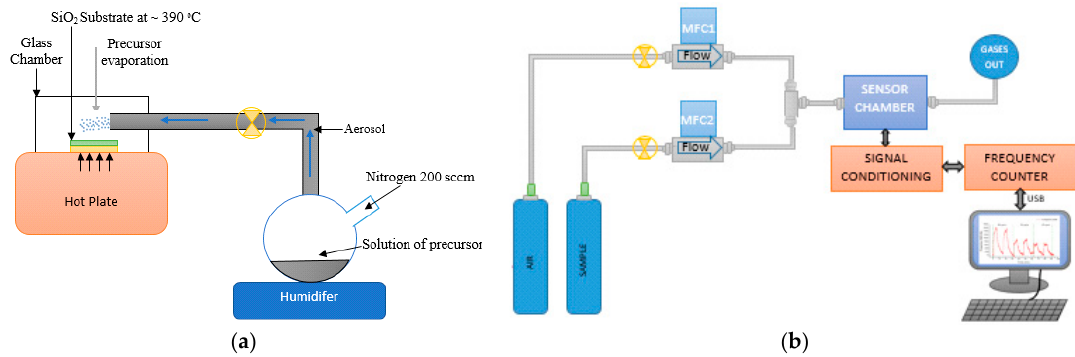
Figure2. ( a ) Basic scheme of aerosol assisted chemical vapour deposition technique; ( b ) Diagram of instrumentation and experimental setup for the gas sensing tests of the Love-wave